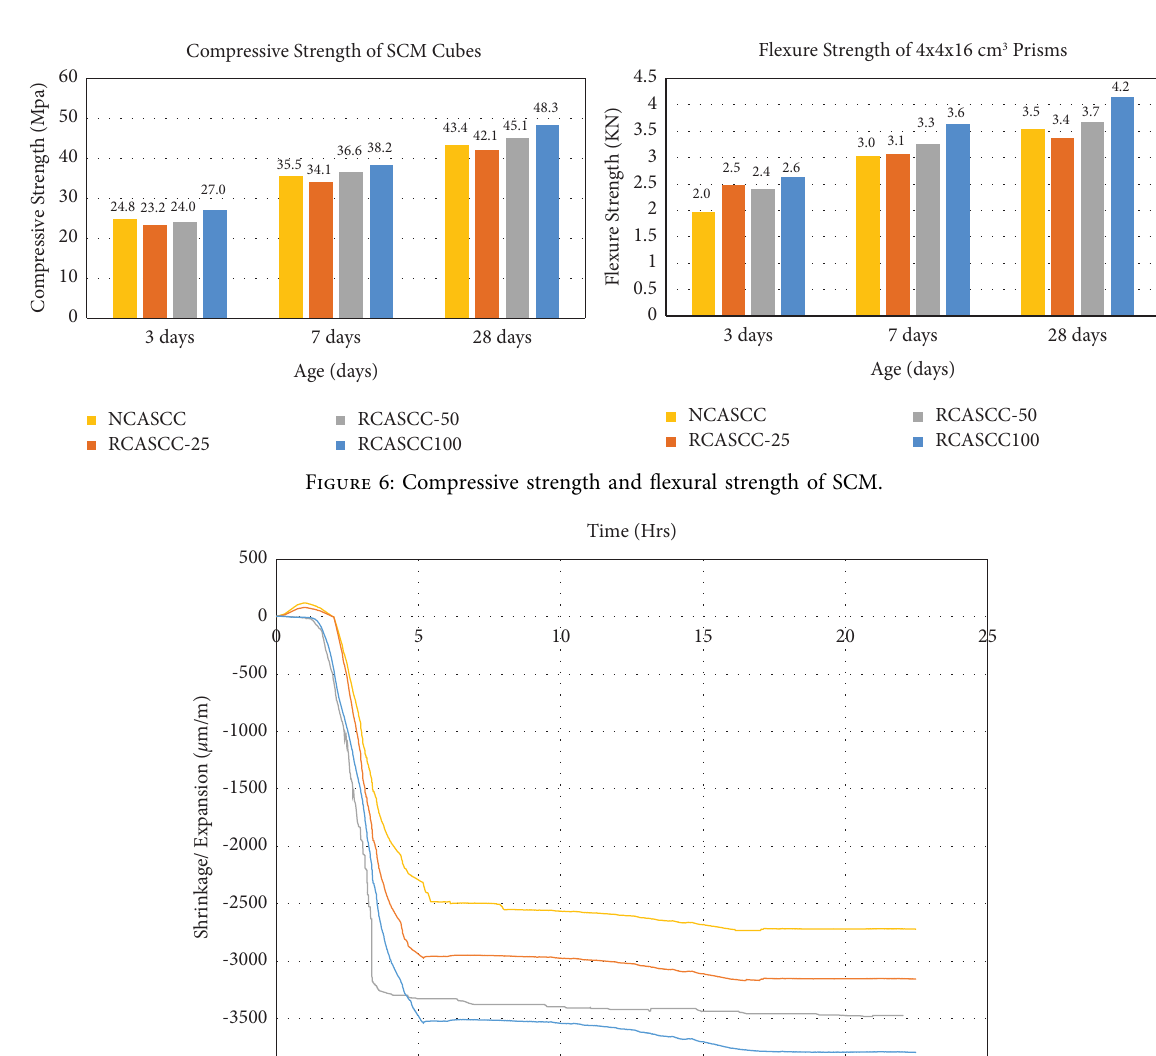
Figure 5: Compressive strength and fexural strength of